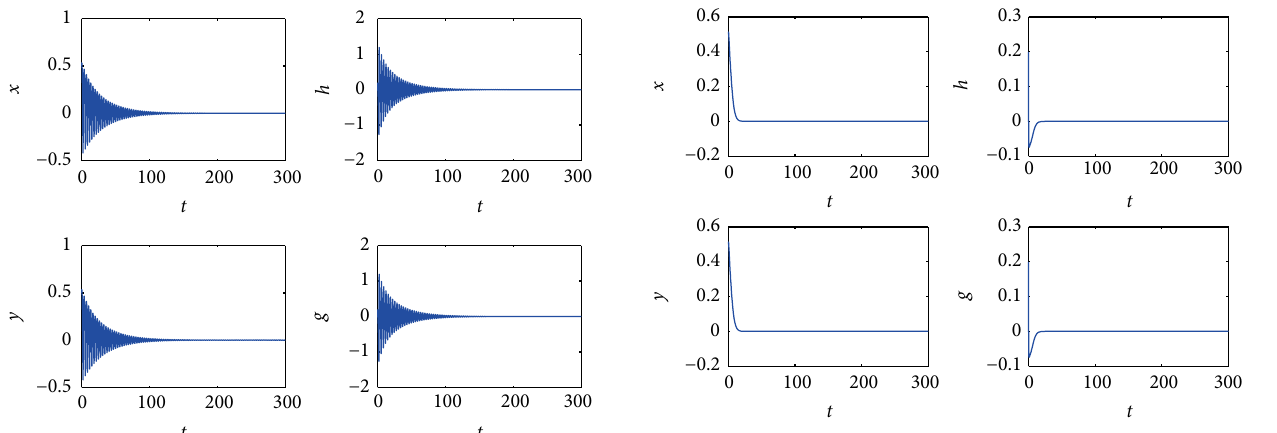
, 𝜀 ) = (−0.4, −0.08) , showing the equilibrium(0 0 0 0) is asymptotically stable. 1 2